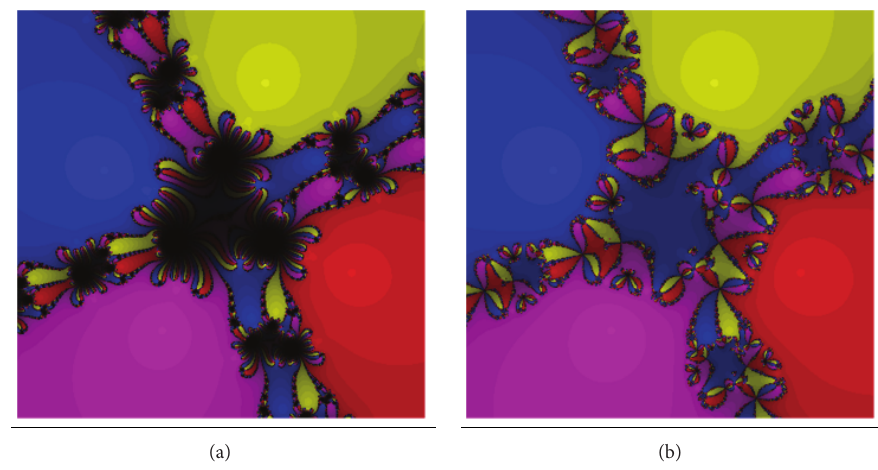
Figure 3: The methods (3) (a) and (5) (b) for Test Problem